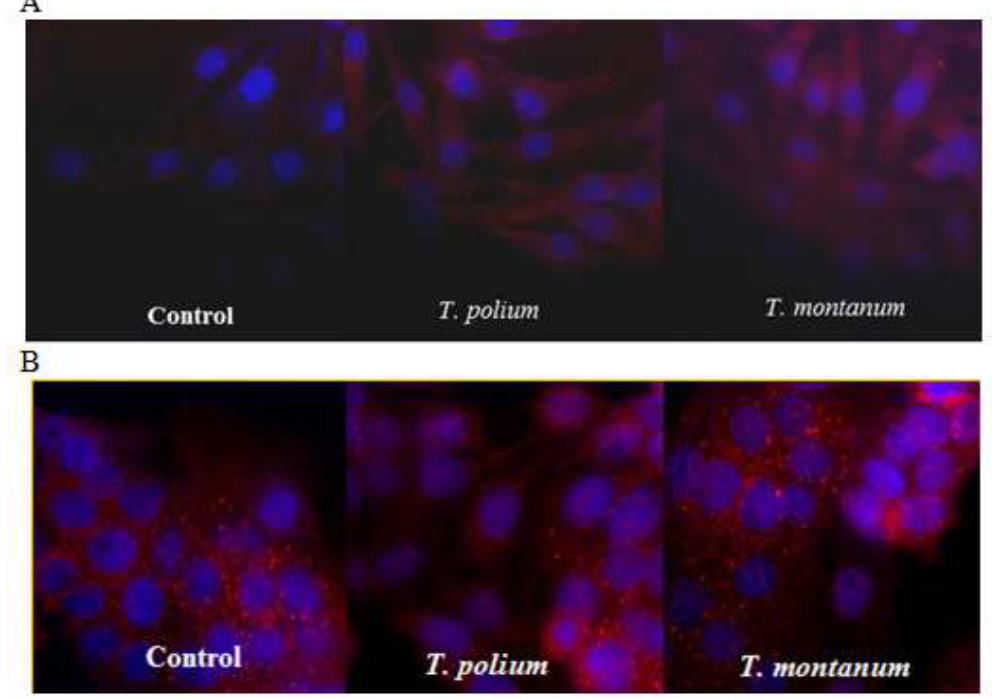
Figure 4. Fas receptors expression on MDA-MB-231 (A) and SW-480 (B) control cells and cells treated by T. polium and T. montanum extracts. Cells were incubated with treatments for 24 h. The images were taken using fluorescence microscopy at 600×. Nuclei were stained blue, Fas receptors were stained red.